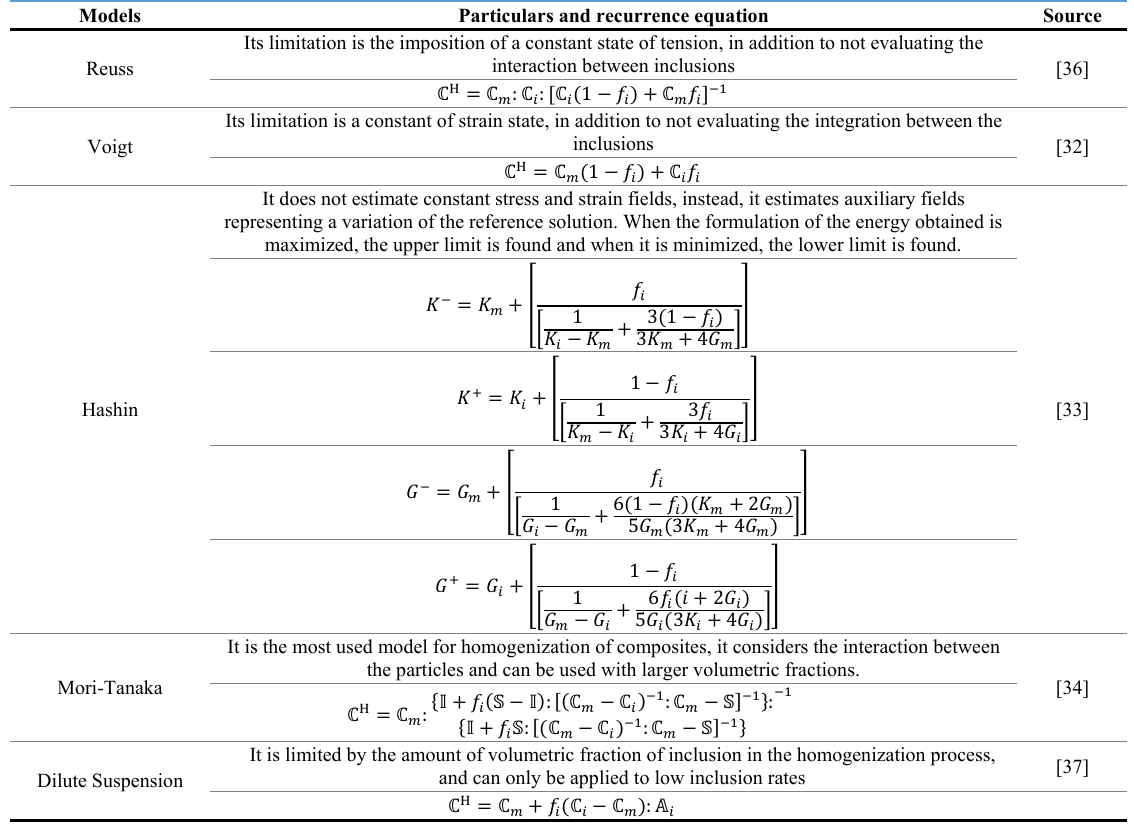
Table 1: Characteristics of homogenization